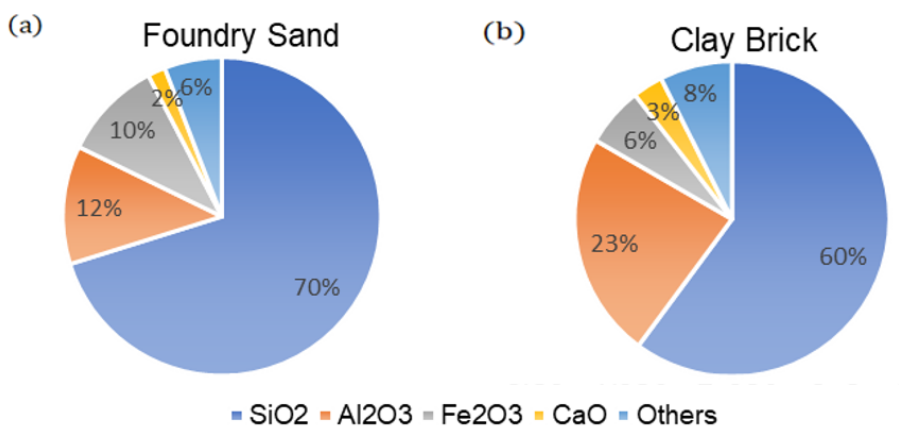
Figure 4. Pie chart of the chemical composition of the materials used ( a ) foundry sand, ( b ) clay